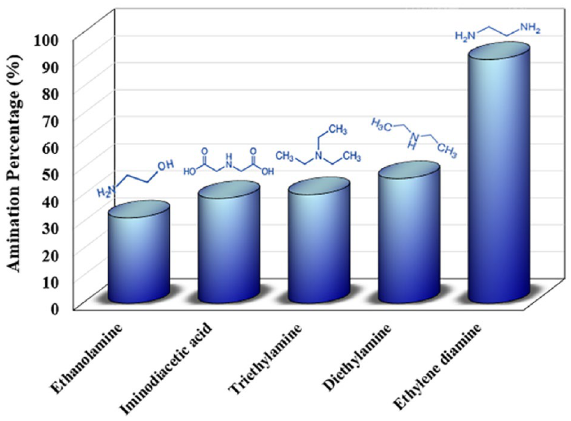
Figure 2. Amination percentage of the modified adsorbent with different